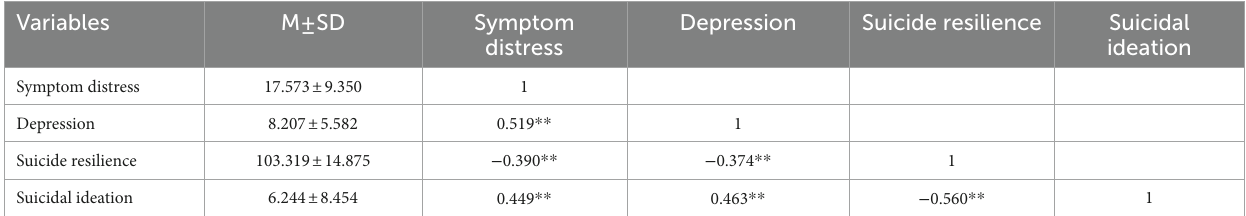
TABLE 2 Correlation analysis among variables in ovarian cancer patients.